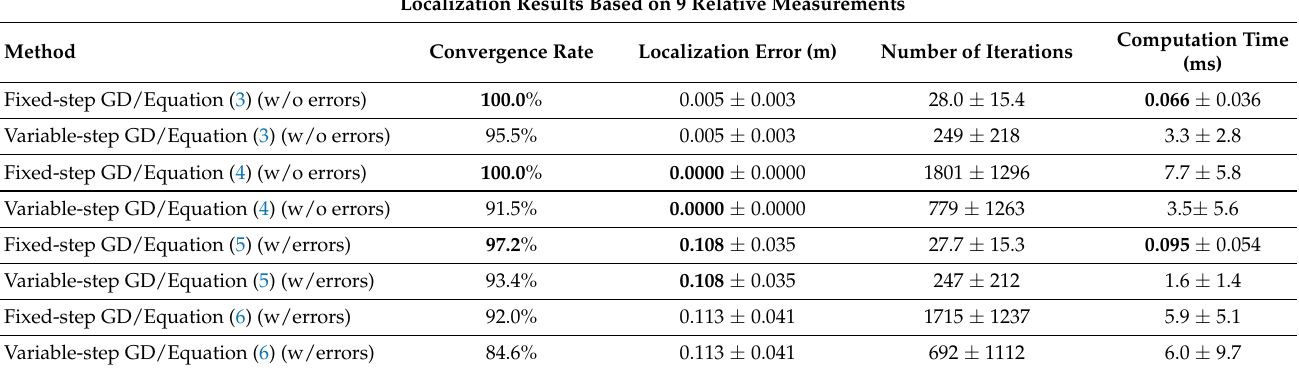
Table 7. Comparative localization results using the different formulations of the estimation problem based on 9 relative measurements, with and without taking into account uncertainty models.